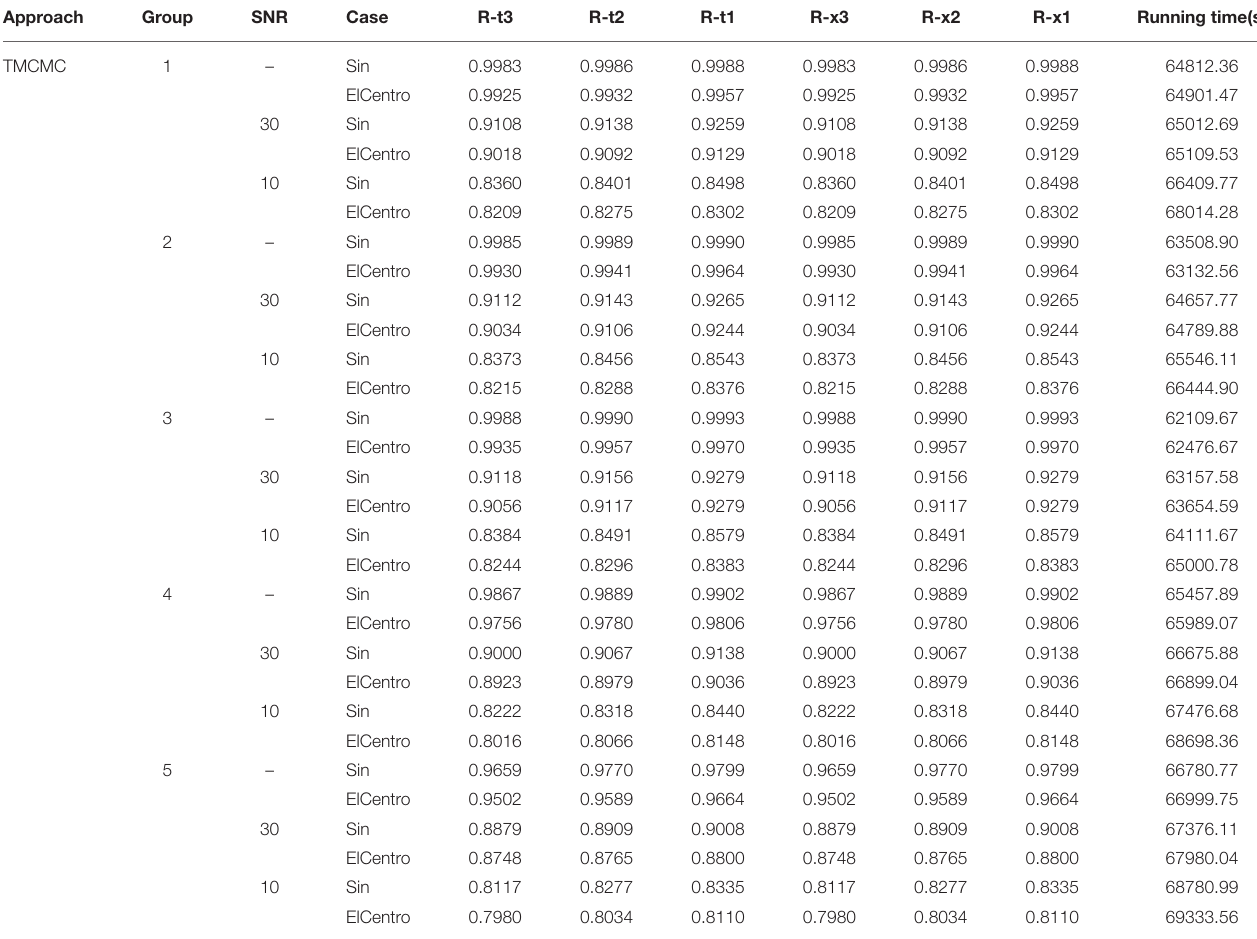
TABLE 7 | Correlation coefficient analysis (TMCMC).